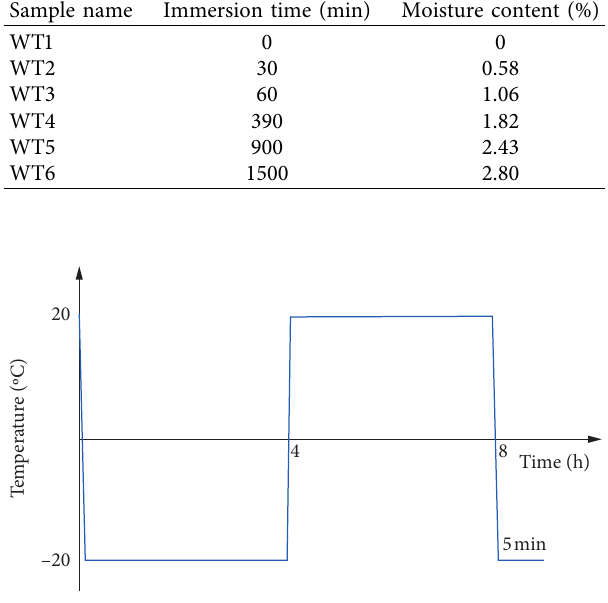
Figure 4: Temperature schematic diagram of each F-T cycle.